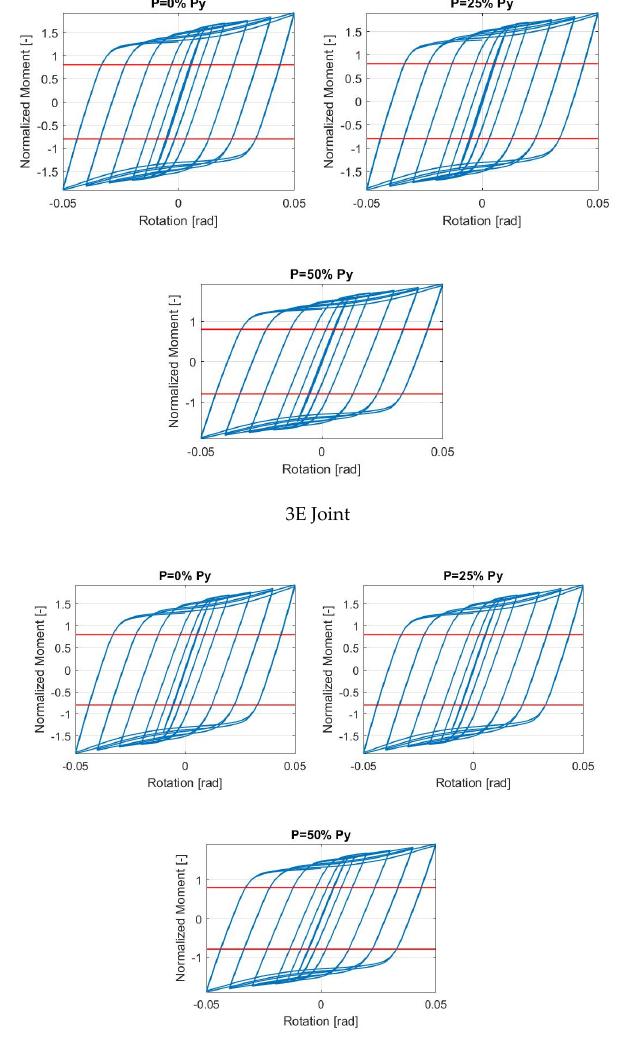
Figure 9. Summary of Normalized Moment-Rotation curves. Note: P, is the axial load applied in numerical model, Py = FyAg, where Fy is the plastic modulus and Ag is the gross area.